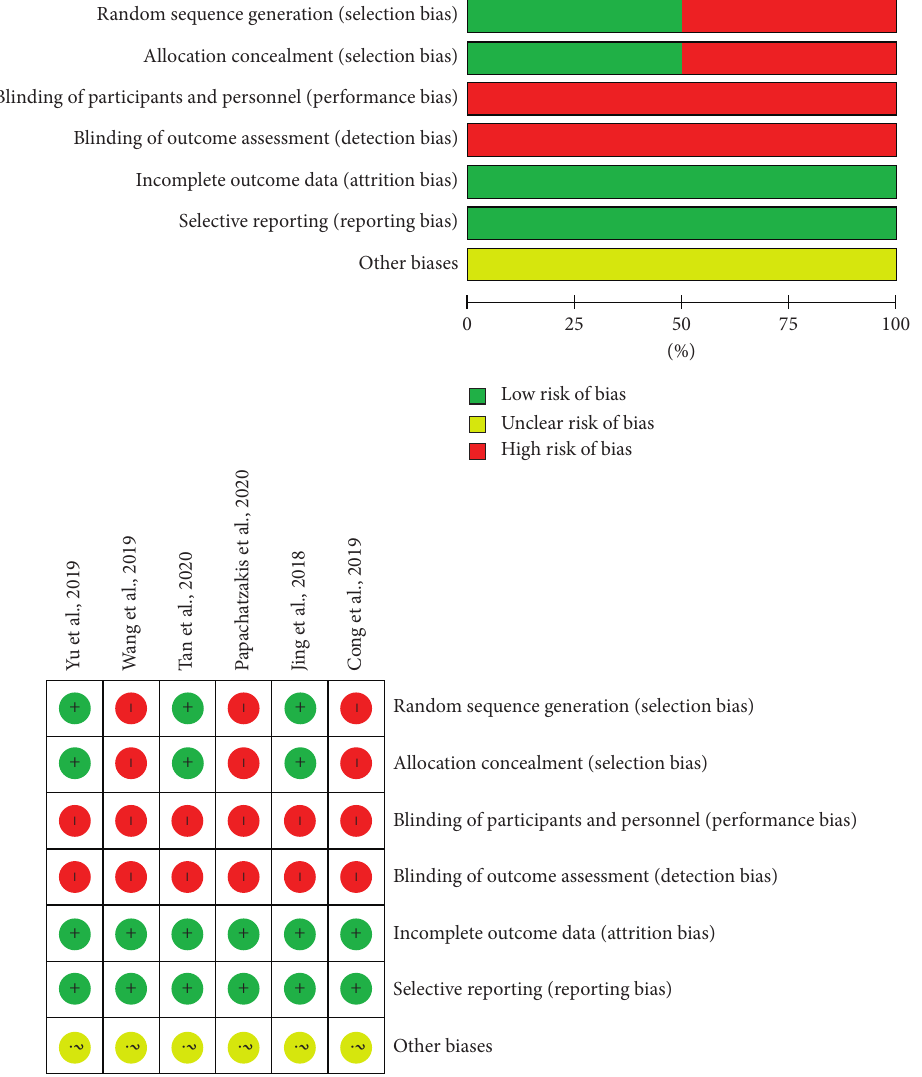
Figure 2: Quality assessment of each eligible